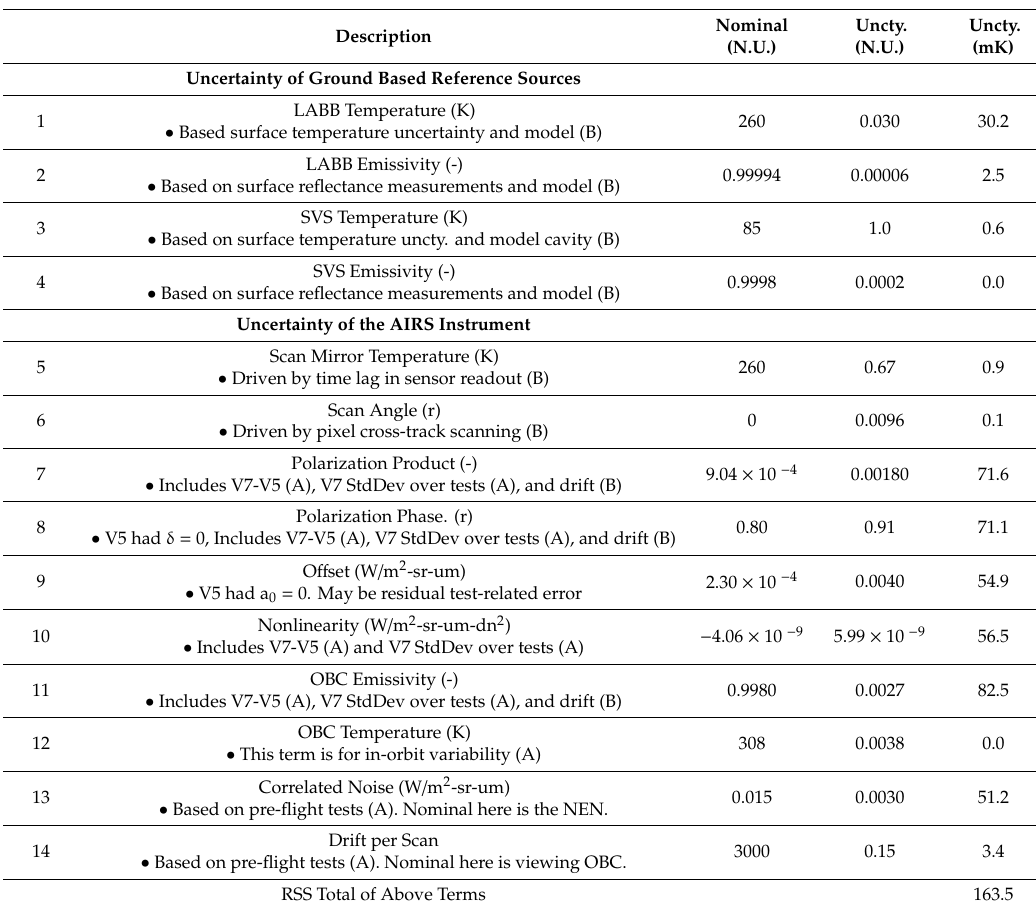
Table 2. Contributors to the AIRS radiometric measurement uncertainty (Uncty.) expressed in their native units (N.U.) and as a temperature uncertainty at 260 K. All values are 1-sigma, and represent the average over all modules of the median over all channels within the module. Error type (A or B) is given for each